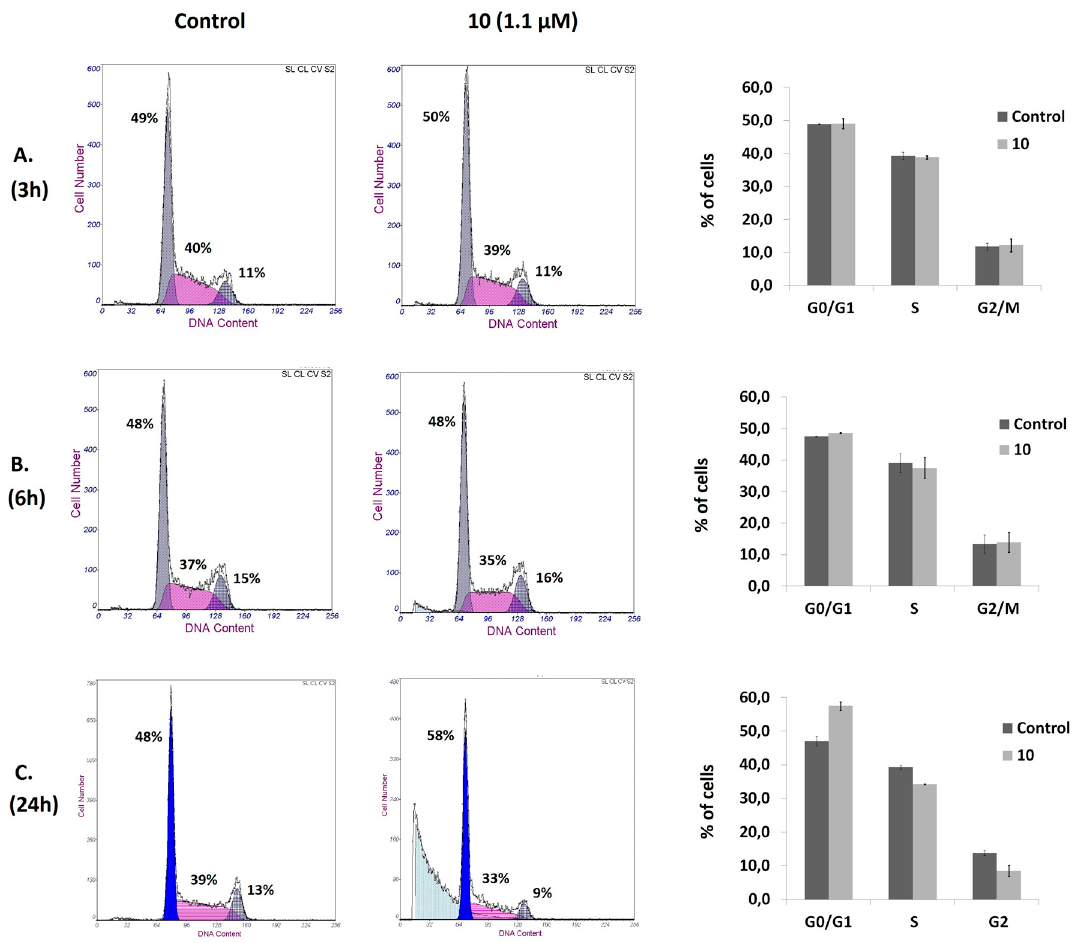
Figure 3. Effect of compound 10 on cell cycle distribution. Cell cycle analysis of Jurkat cells untreated (Control) or treated with 1.1 µ M compound 10 for 3 ( A ), 6 ( B ), and 24h ( C ). After treatment, cells were stained with PI and DNA content analyzed by flow cytometry. A representative histogram is shown for each time of incubation and condition. Results are presented as means ± SD of three independent